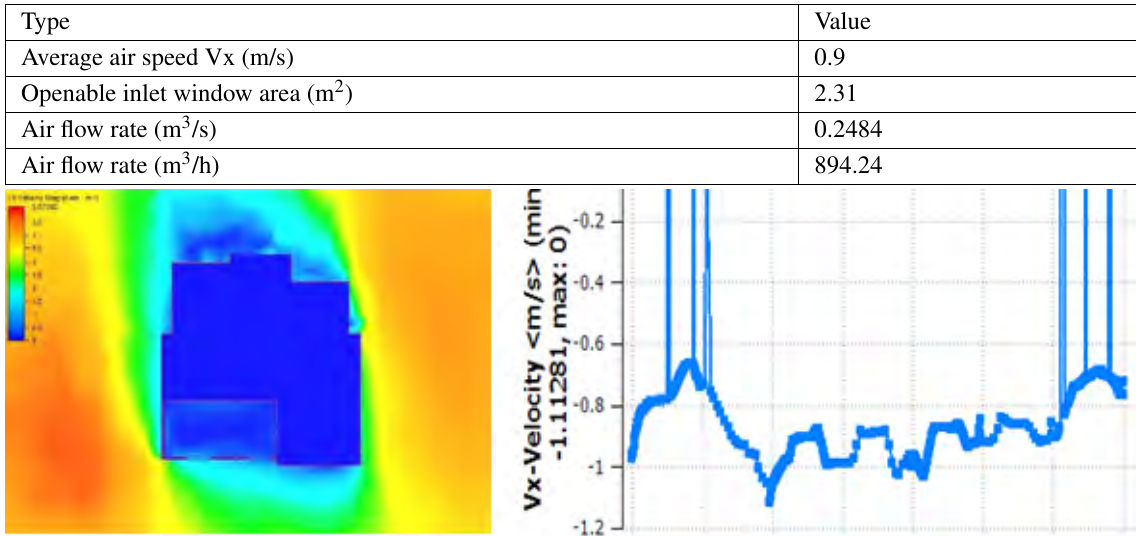
Table 2. The environmental specifications related to the ventilation aspect